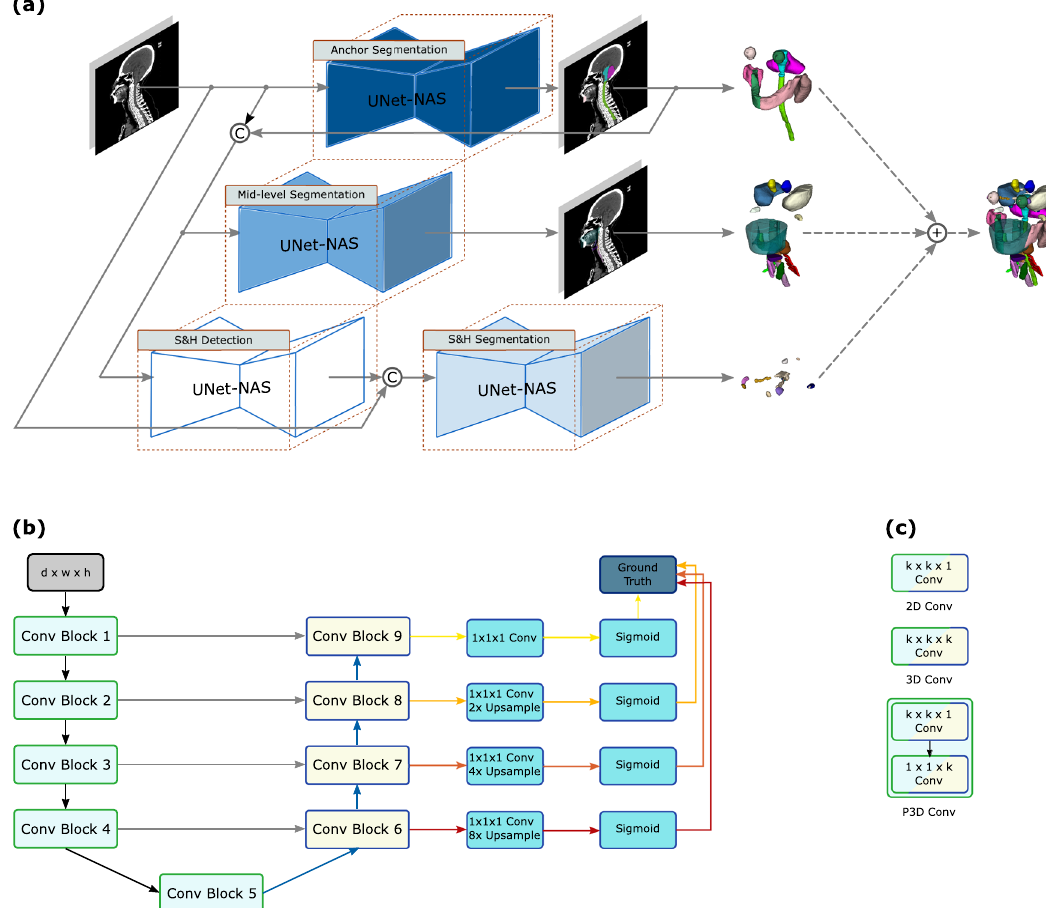
Fig.5|Thestrati fi edorganatrisksegmentation(SOARS)method.a SOARS fi rst strati fi es OAR into anchor, mid-level, and small & hard (S&H) categories and uses the anchor OARs to guide the mid-level and S&H OAR segmentation. b